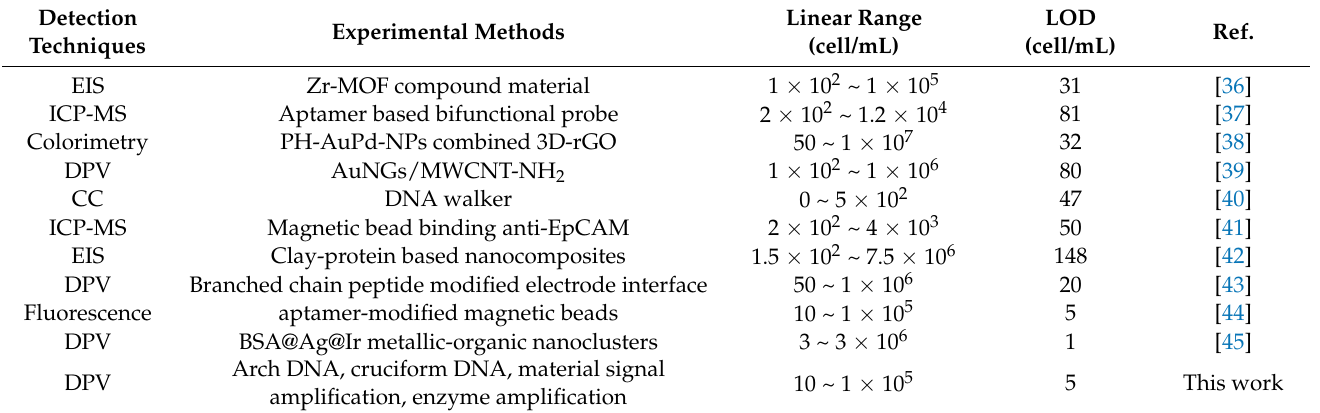
Figure 5. Detection performance of the sensor: ( A ) DPV curves of different concentrations of MCF-7, with the concentration of a~i: 0, 10, 10 2 , 5 × 10 2 , 1 × 10 3 , 5 × 10 3 , 1 × 10 4 , 5 × 10 4 , 1 × 10 5 cells/mL, respectively; ( B ) the relationship between the DPV current and the concentration of MCF-7. The inner illustration shows the linear relationship between the peak current of DPV and the logarithm of the MCF-7 cell concentration. The error bar represents the standard deviation of three measurements. Table 1. Comparison between the constructed sensor and other sensors for detecting